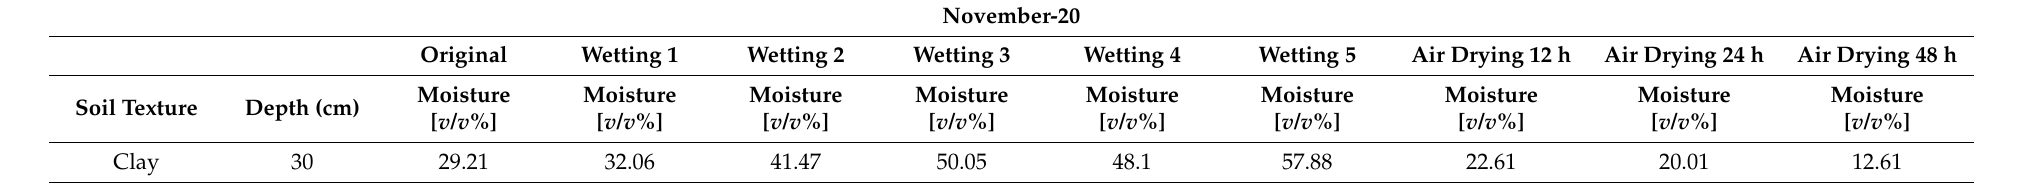
Table 7. Clay Laboratory calibration—Volumetric water content from Gravimetric method.